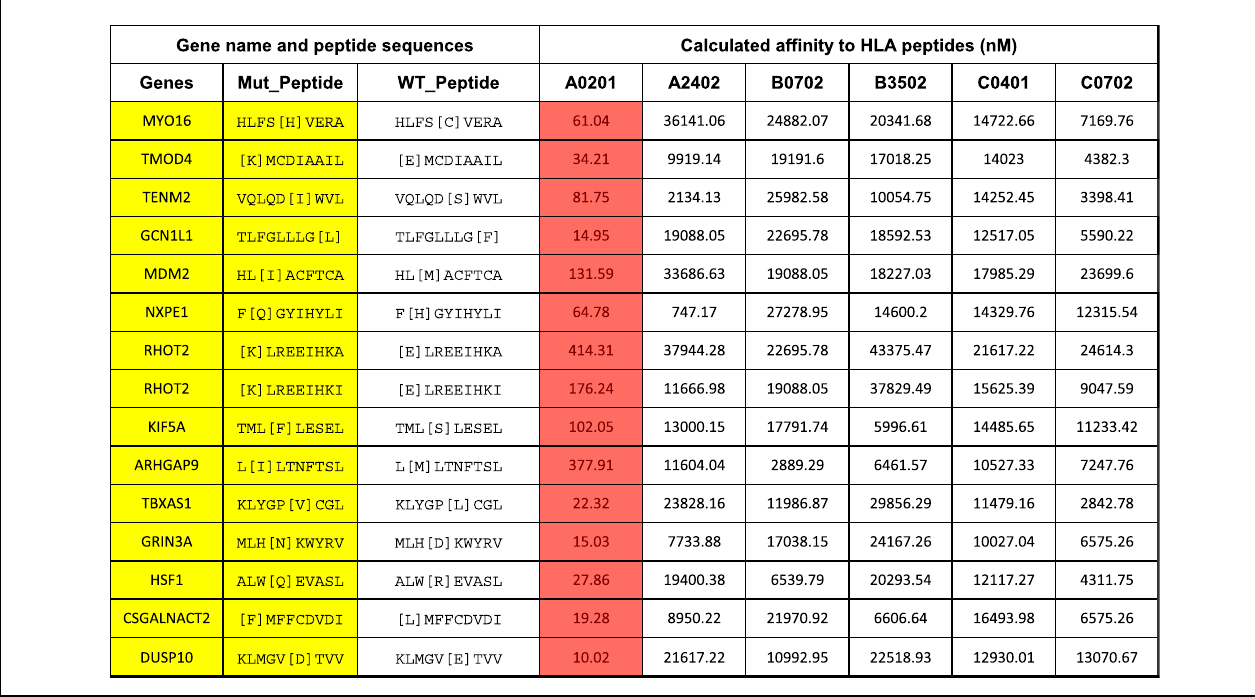
Table 1 Table showing the gene name, mutant neopeptide (yellow), wild type peptide sequence (yellow) and predicted nanomolar af fi nity for the HLA-A/B/C found in NSCLC samples from a patient with HLA*A2 type over the course of disease. The calculated af fi nity of the mutant peptides for HLA*A2 is highlighted with red colored